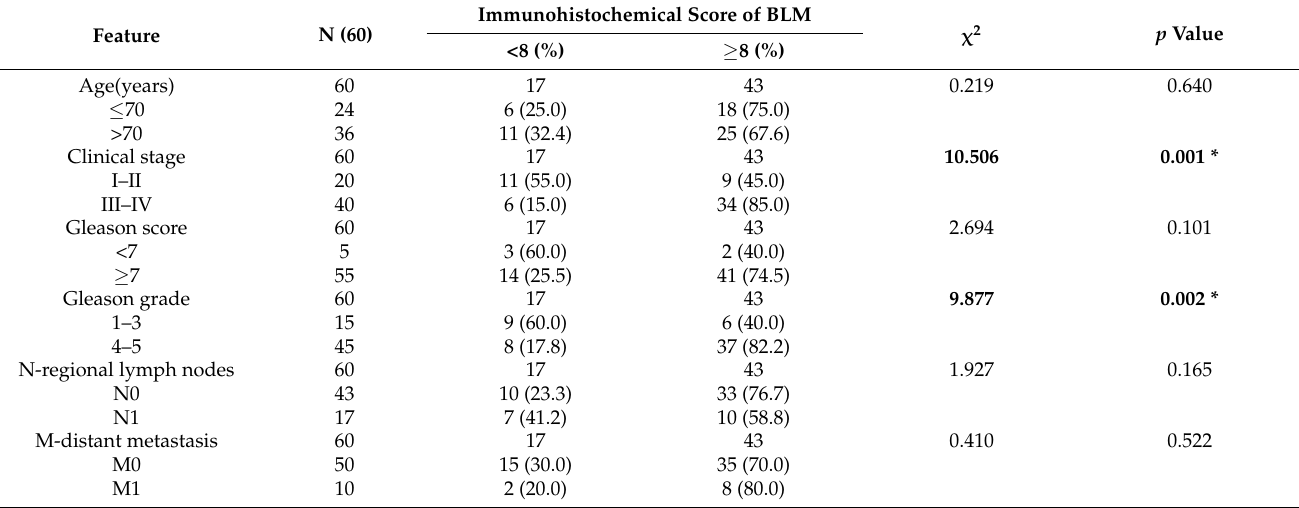
Table 1. Relationships of BLM and clinicopathological characteristics in 60 patients with